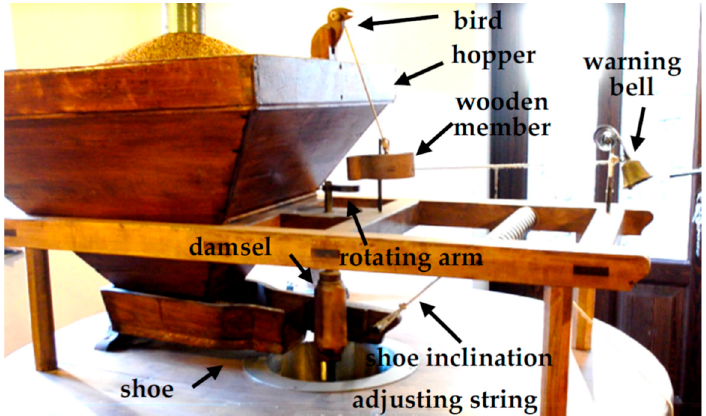
Figure 20. Grain flow adjustment mechanism and hopper emptying alarm (Riviera mill).